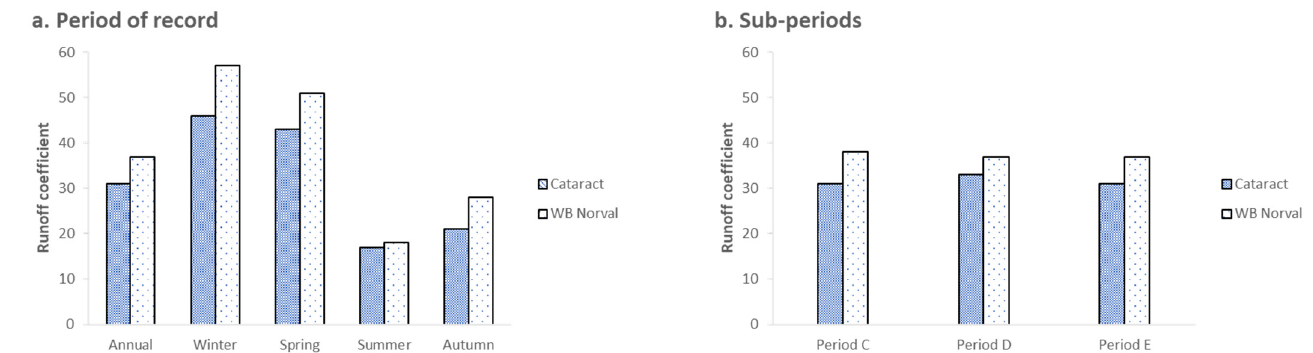
Figure 13. Runoff coefficients of the rural and urban sections of the watershed. ( a ) Period of record, ( b ) Sub-periods.